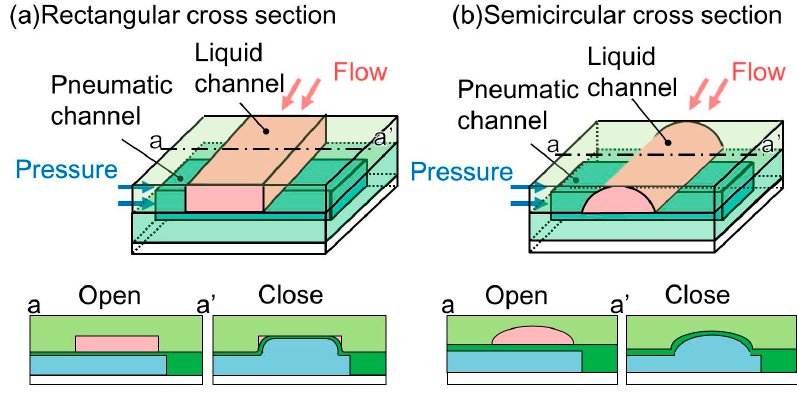
Figure 1. Conventional cross sections of microchannels of pneumatic pressure-driven microvalves. ( a ) Rectangular cross section; ( b ) Semicircular cross section.